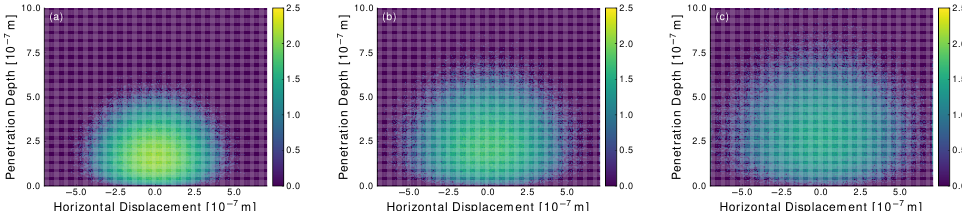
Figure A3. Heatmap of the electron cloud at 2.83 × 10 − 11 s after impact, with the LµJ surface for l = − 1 ( a ), l = 0 ( b ) and l = 1 ( c ) according to Equation (A17). For this model, 10 7 1 eV electrons were simulated through a 15 µm LµJ with the jet directed into the page. The electron counts for each corresponding depth and horizontal displacement were then recorded. A log non-zero values was then performed for visualisation purposes. Initially, in each scenario, the elastic cross-section is equal due to the initial energy of 1 eV. In ( a ), the electron swarm loses energy through collisions with the background gas and experiences an increasing cross-section (decreasing mean free path) with energy loss, which results in a decreased expansion of the electron swarm. In ( b ), the electron swarm experiences a constant cross-section (constant mean free path) with energy loss, which results in a steady expansion of the electron swarm. Finally, in ( c ), the electron swarm experiences a decreasing cross-section (increasing mean free path) with energy loss, which results in an increased expansion of the electron